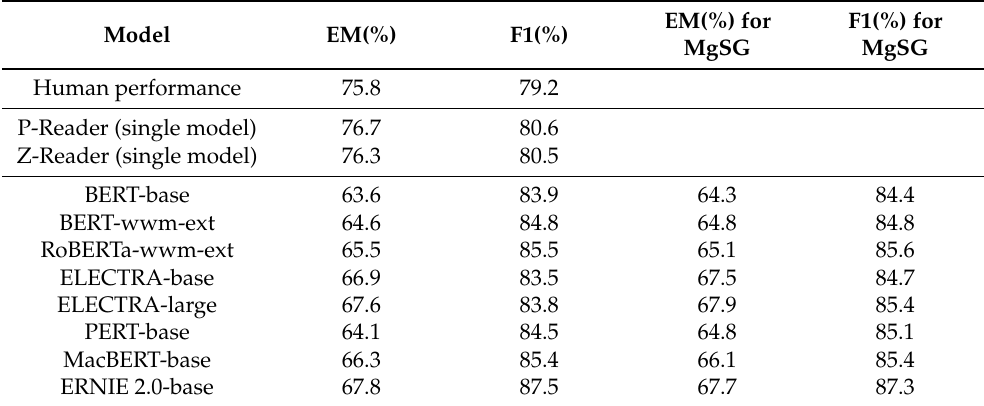
Table 2. Results for CMRC-2018 dev dataset. The results of the experiments are obtained in our local environment and the corresponding literatures.